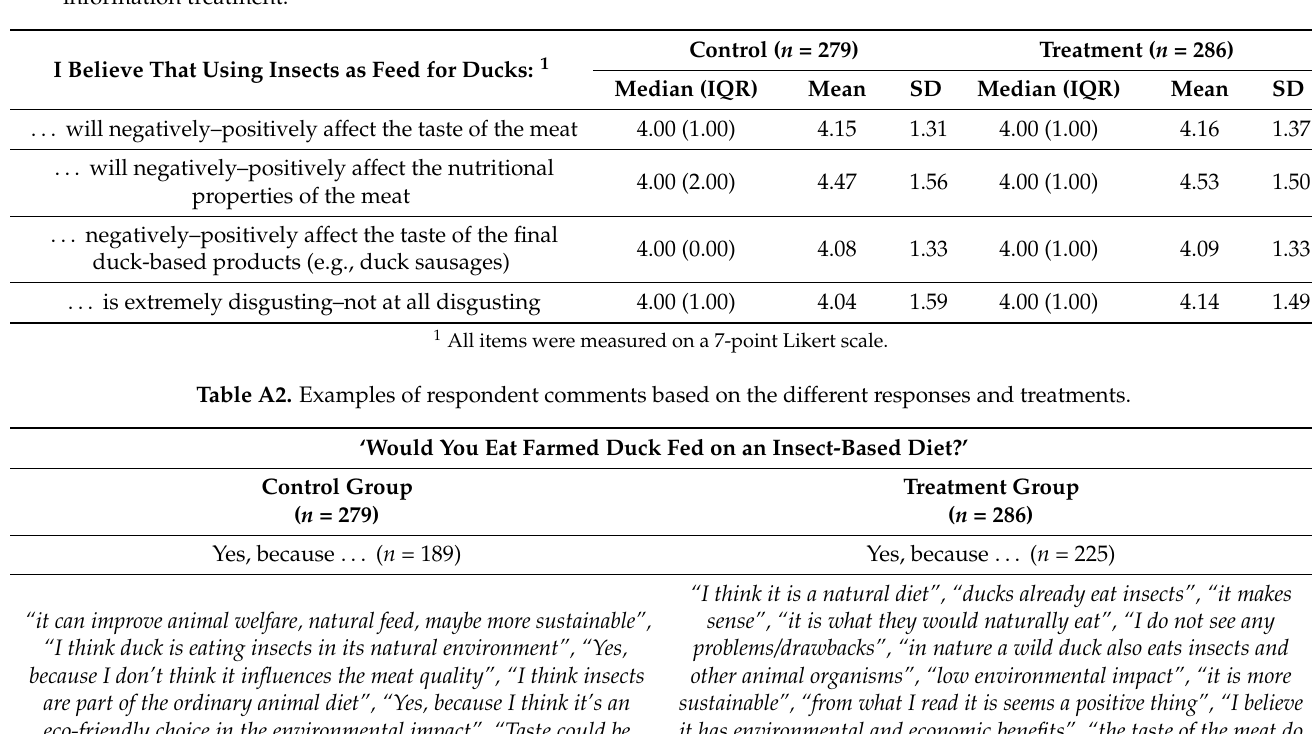
Table A1. Items for measuring consumers’ attitudes towards eating a farmed duck fed with insect-based meal—pre- information treatment.